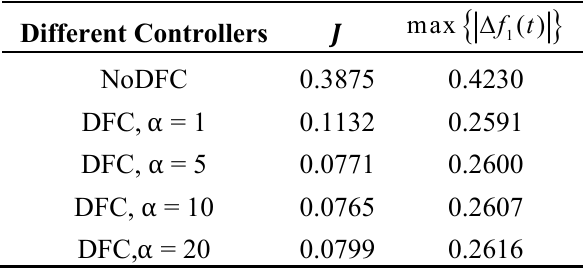
Table 3. The performance index under different controller parameters with a short-circuit fault ( β =